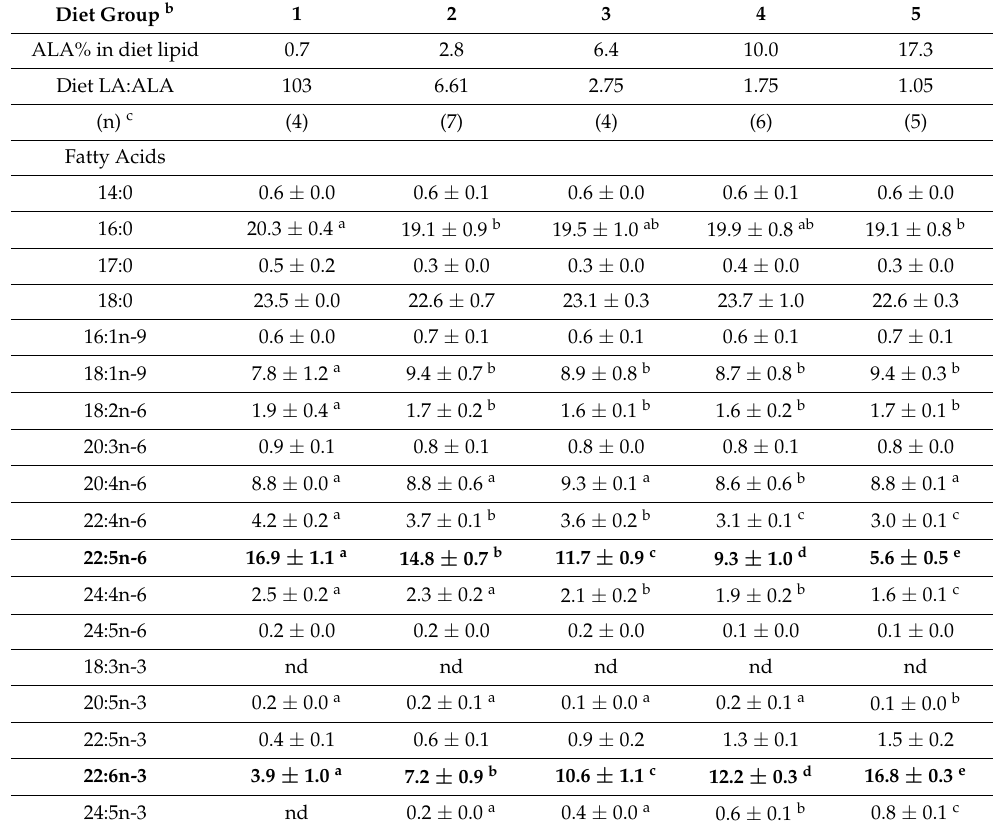
Table 1. Effect of increasing dietary ALA on retinal fatty acid proportions (g/100 g phospholipid fatty acids) a .